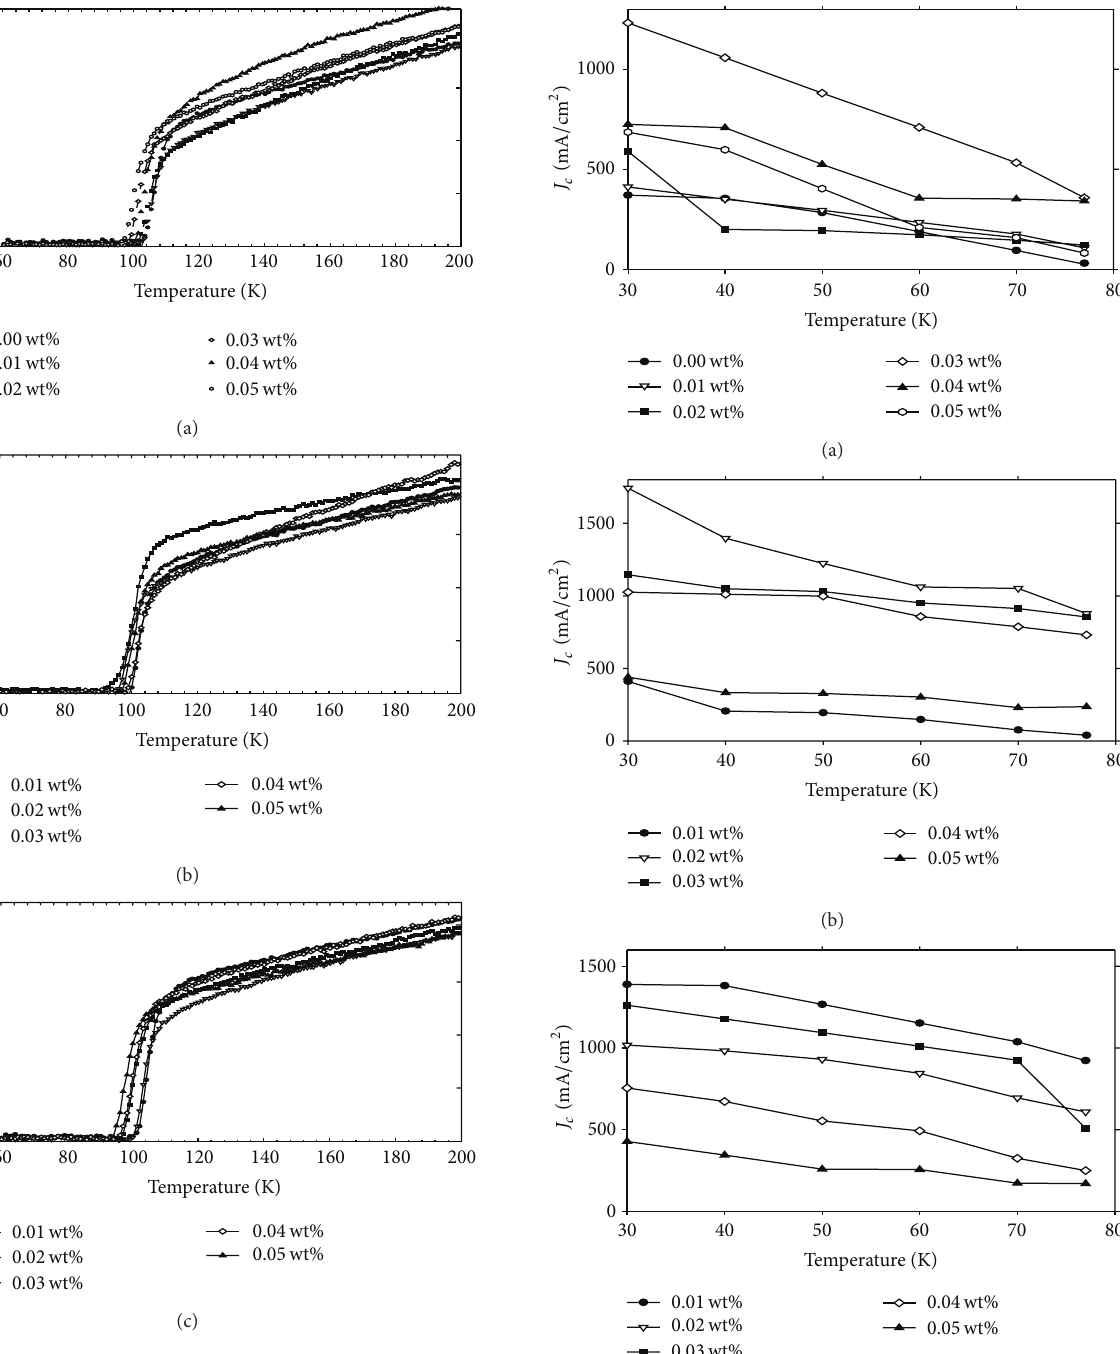
Figure 5: Electrical resistance versus temperature curve for (a) nonadded sample and 10nm Co 3 O 4 added samples, (b) 30 nm Co 3 O 4 added samples, and (c) 50nm Co 3 O 4 added samples. Figure 6: The critical current density as function of temperature for (a) 10 nm, (b) 30 nm, and (c) 50 nm Co 3 O 4 added Bi-2223 samples. the Y-based [23] and Bi-based [24] polycrystalline supercon- Co 3 O 4 (30 nm) sample. At 77 K, 𝐽 𝑐 of the 10 nm and 30 nm ductors. It is clear that the addition of a small amount of Co 3 O 4 added samples was 6 and 13 times larger than the nonadded samples, respectively. However, the addition of Co 3 O 4 enhanced the current-carrying capacity of the Bi-2223 ceramics. For the undoped sample, the 𝐽 𝑐 at 77 K is about Co 3 O 4 (50 nm) decreased the 𝐽 𝑐 at 77 K (0.01–0.05 wt.%) 26 mA/cm 2 . The highest value of 𝐽 𝑐 was observed in the compared to the nonadded sample. The 𝐽 𝑐 of the sample 𝑥 = 0.02 wt.% 𝑥 = 0.03 wt.% Co increased to 358 (mA/cm 2 ) in the 0.03 wt.% Co 3 O 4 (30 3 O 4 (10 nm) sample and